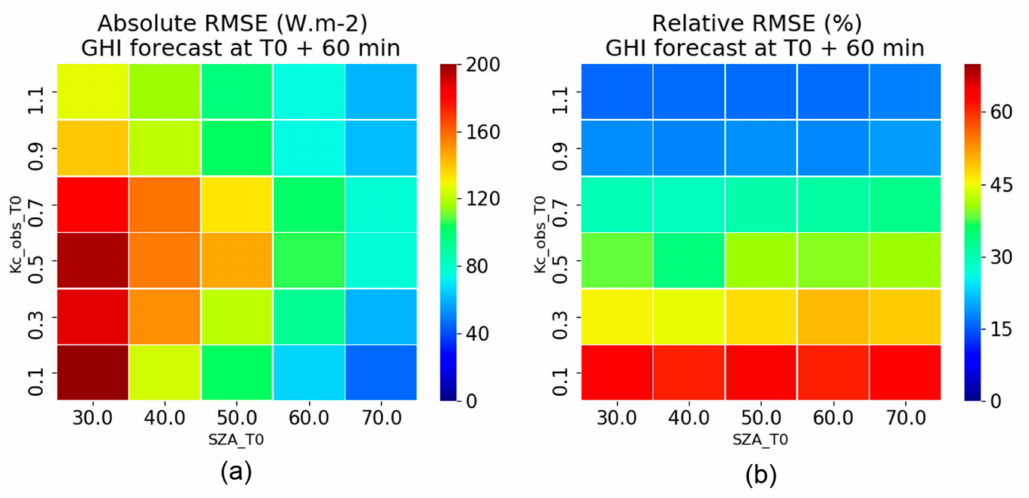
Figure 7. Heatmaps representing the RMSE ( a ) and relative RMSE ( b ) in function of K c_obs classes (unitless) and SZA classes (express in degrees) for all forecast from 1 July 2017 to 30 June 2020 with SZA inferior to 78 ◦